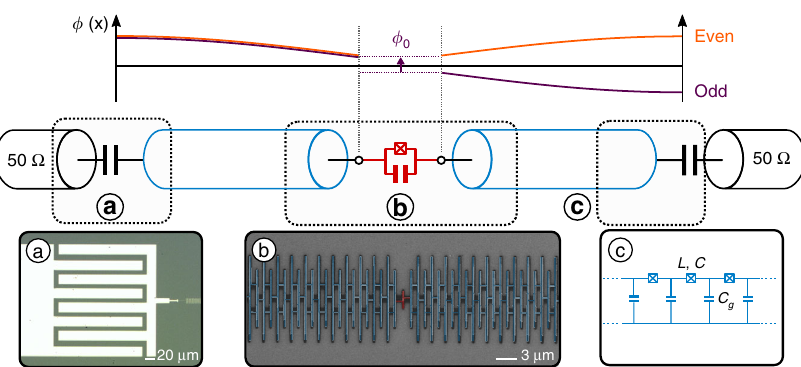
Fig. 1 SQUID chains coupled to a small Josephson junction (weak link). The upper part represents the spatial phase distribution of the two fi rst standing waves or resonant modes of the total system (Josephson junction + chains). And odd (even) mode — which couples (does not couple) to the junction — is represented in purple (orange). The lower part is a schematic of the system. The SQUID chains, depicted as blue transmission lines, are capacitively coupled to the input and output 50 Ω coaxial cables and galvanically coupled to the small Josephson junction (in red). a Optical picture of the input and output capacitive couplings. b SEM picture of a few of the SQUIDs (1500 in total for each chain) that are coupled to the small Josephson junction (in red). c Equivalence between the transmission line effective picture and the SQUID chain characterized by three microscopic parameters L and C the inductance and capacitance per SQUID respectively and C g the ground capacitance